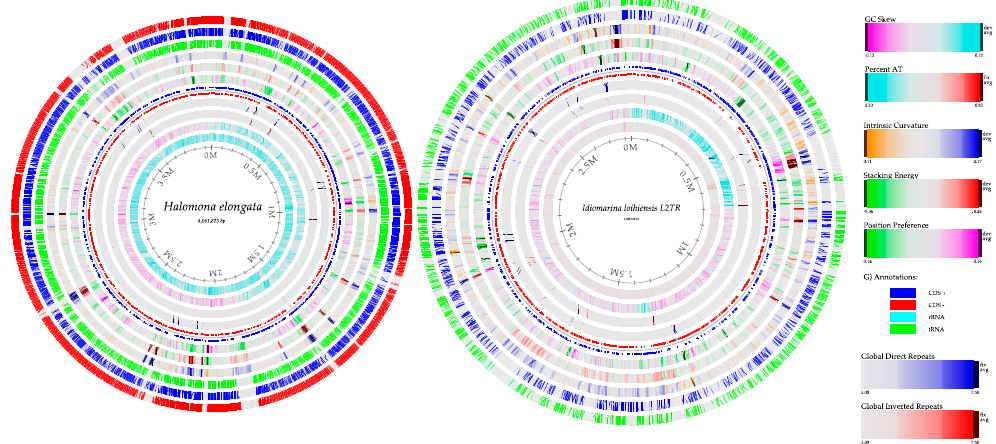
Figure 6. Draft genome comparison of Halomonas elongata and Idiomarine loihiensis . From the outside to center of the genomes of Halomonas elongate -like from Acos 2 (red) and Acos 1 (blue), the innermost rings show percent AT, GC skew, GC content, global inverted repeats, CDS-, CDS + , position preference, stacking energy, and intrinsic curvature, which are colored in a gradient, and the interpretation of the references to color is in the figure legend. The Idiomarine loihiensis -like genome from Acos 2 (green) and Acos 1 (blue) and the innermost rings show the same interpretation of genome H. elongata . Table 2. Features of Halomonas elongata and Idiomarina loihiens is genomes with number of transfer RNA (tRNA), transfer-messenger RNA (tmRNA) and ribosomal RNA (rRNA).